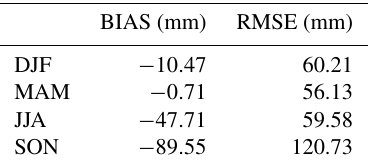
Figure 2. (a) shows the average annual rainfall map over the Lig- uria area, (b) shows the average observed annual rainfall map and (c) shows their difference in mm. Table 4. Comparison between seasonal rainfall observations and EXPRESS-Hydro. Skill scores estimated on a seasonal